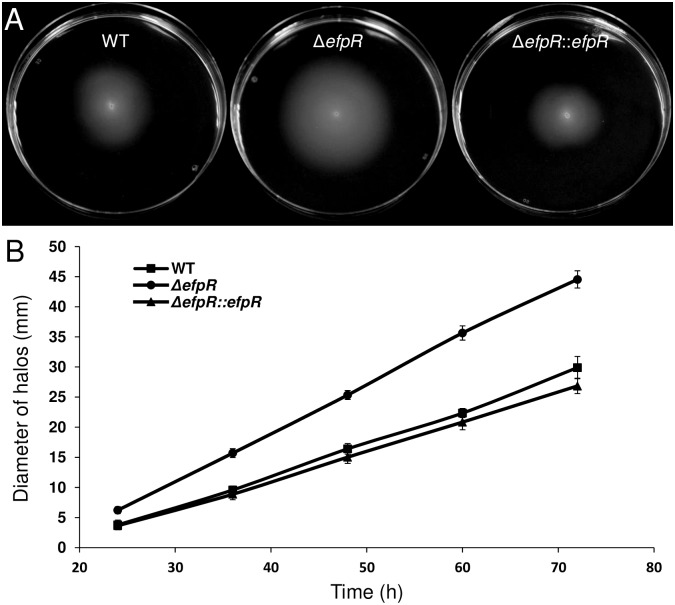
Deletion of efpR results in improved swimming motility of R. solanacearum GMI1000.(A) Swimming motility assay on MP minimal medium semi agar (0.3%) plates supplemented with L-Glutamate 20 mM. Representative pictures of swimming halos observed after incubation at 28°C during 72h. (B) The diameter of halos has been measured through the time. The experiment was repeated twice, with ten plates for each strain per replicate. Bars indicate standard deviation.